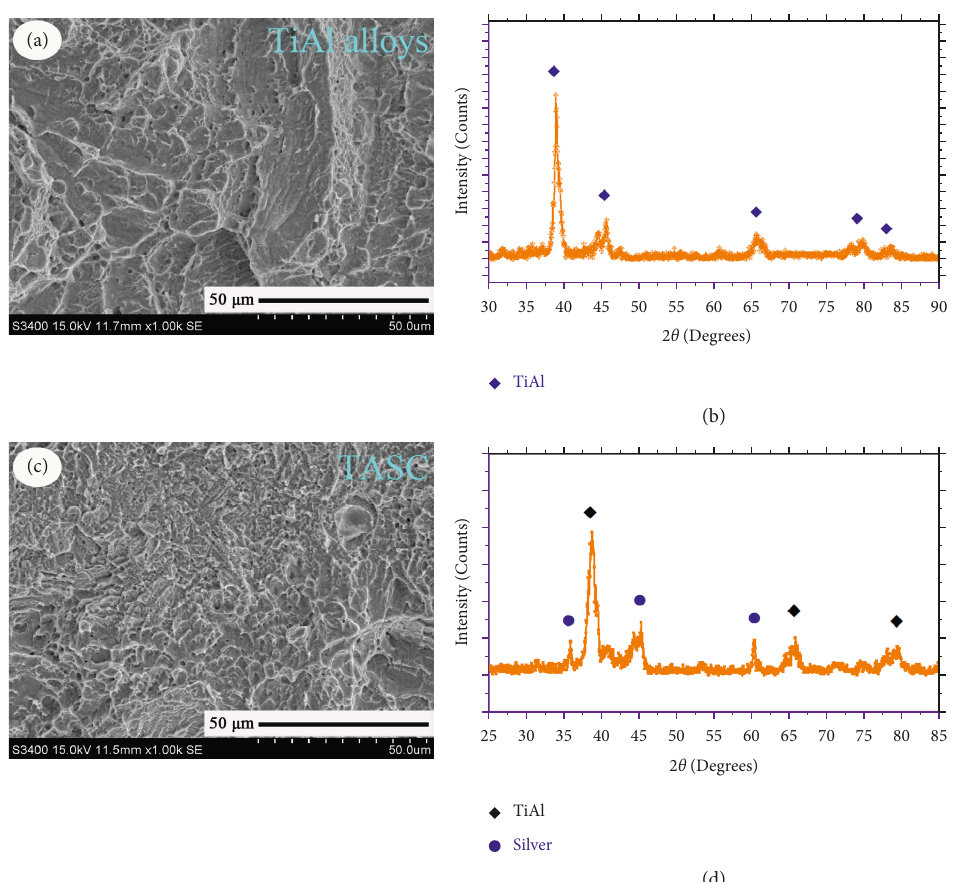
Figure 2: Typical FESEM cross-section microstructures and the XRD patterns of TiAl (a and b) and TASC (c and d).